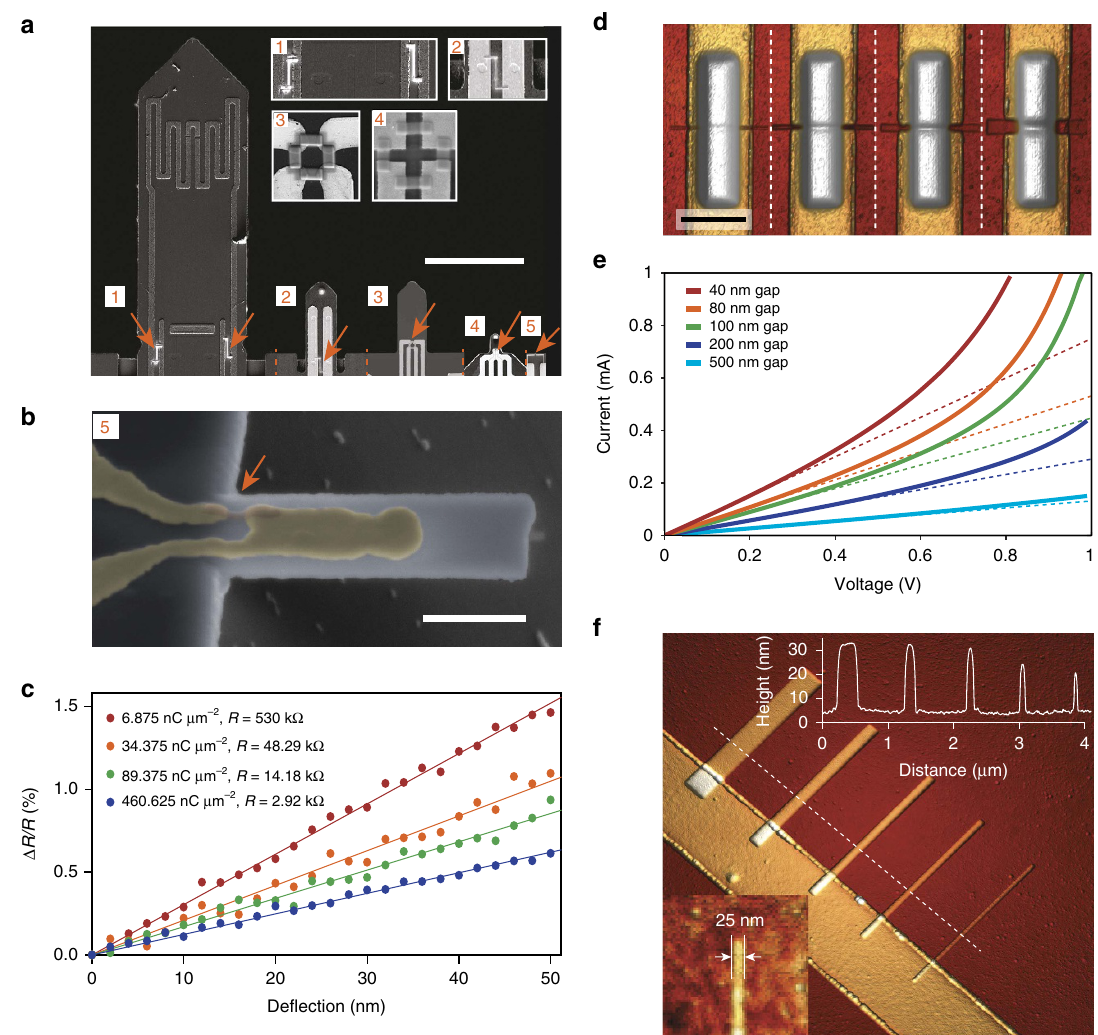
Figure 3 | Scalability of nanogranular tunnelling resistor sensors. ( a ) Nanogranular tunnelling resistor (NTR) sensors deposited on a variety of custom- made atomic force microscopy (AFM) cantilevers spanning two orders of magnitude. Scale bar, 100 m m. ( b ) Scanning electron microscopy image of a 1.5 (cid:4) 0.5 (cid:4) 0.1 m m 3 cantilever with NTR sensor. Scale bar, 500nm. ( c ) Dose-dependent deflection curves of a 500nm wide cantilever (see gauge